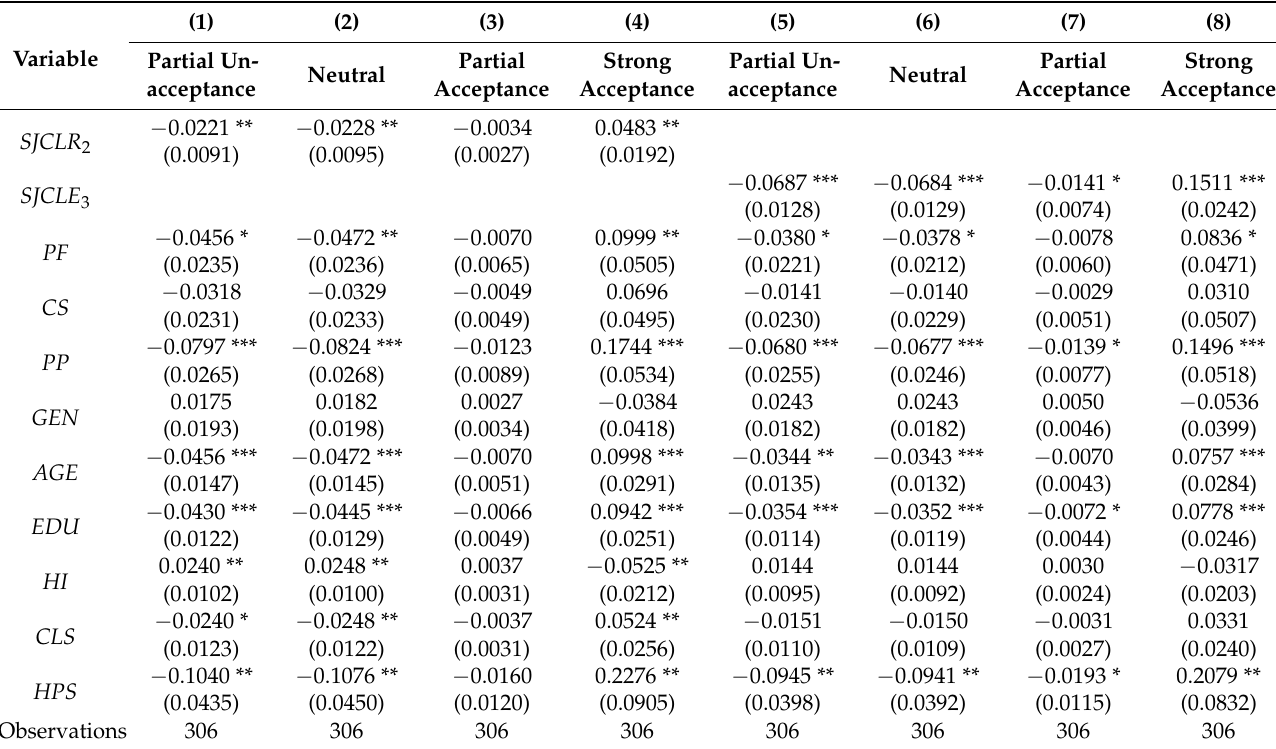
Table 6. Marginal effects of explanatory variables in the ordered probit model. (Transformation core explanatory